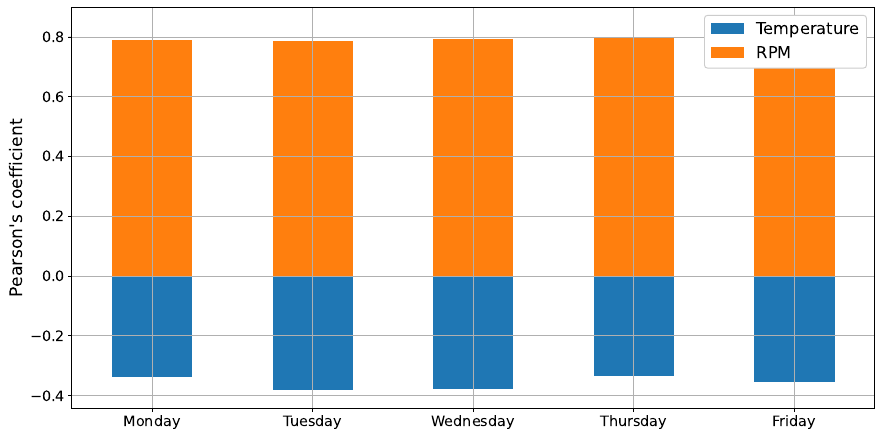
Figure 6. Pearson’s coefficient for each